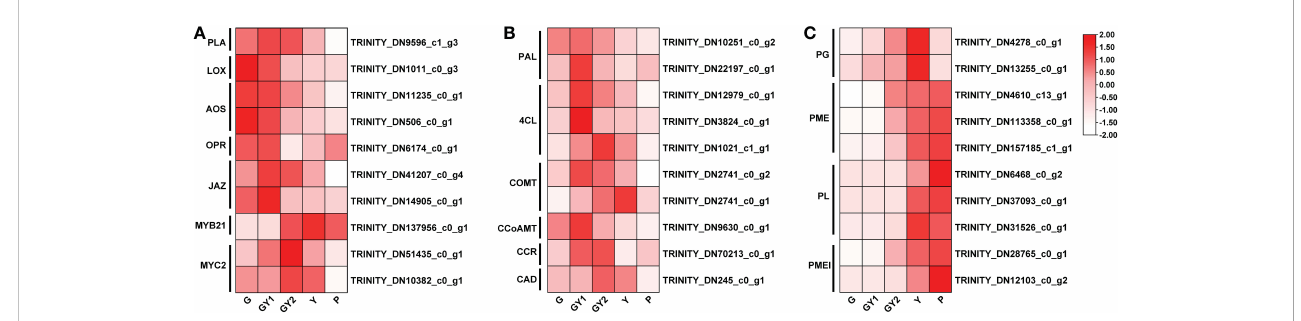
FIGURE 5 Differentially expressed genes (DEGs) involved in selected pathways associated with anther development. (A) Heat maps of the DEGs involved in jasmonic acid biosynthesis and signal transduction. (B) Heat maps of the DEGs associated with the lignin synthesis pathway. (C) Heat maps of the DEGs associated with pectinase activity. The red rectangles represent upregulated genes, and the white rectangles represent downregulated